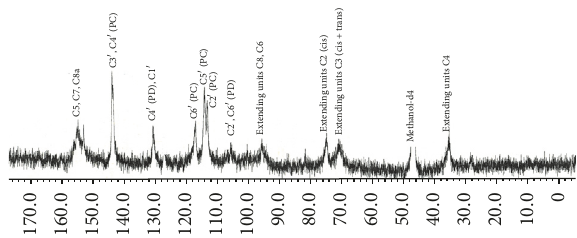
Figure 3: 13 C-NMR spectrum of the purified methanol fraction from tea mangrove